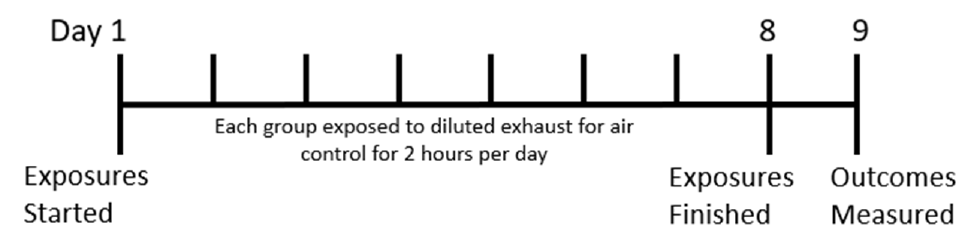
Figure 9. Exposure timeline. Each group was exposed for two hours once a day for 8 days to the same diluted exhausts or Air as a control. Measurements were taken 24 h after the last exposure.